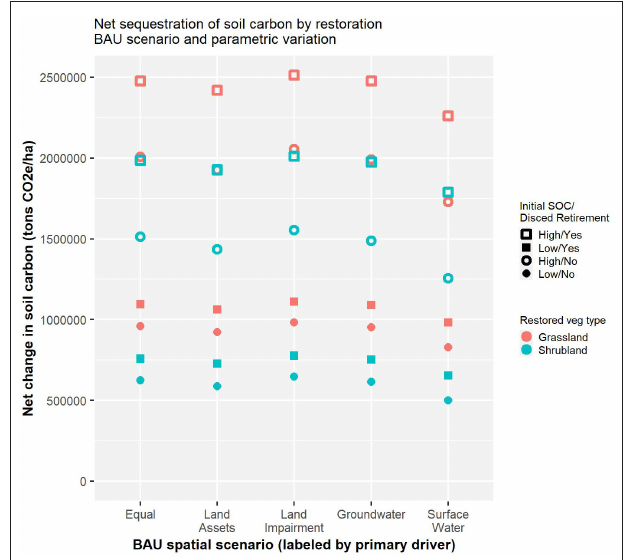
FIGURE 7 | Positive impact of restoration on soil carbon through 2100, reported as CO 2 e for comparison to social costs and other GHG sources. The results assume that 5% of the lands identified for restoration are restored each year from 2021 to 2040, but present cumulative totals as of the year 2100. Initial SOC refers to whether the soil carbon in 2020 was assumed to be a high value (100 t/ha) or low (40 t/ha). Disced retirement refers to whether retired land is routinely disturbed to prevent weed growth that could contaminate nearby cultivated